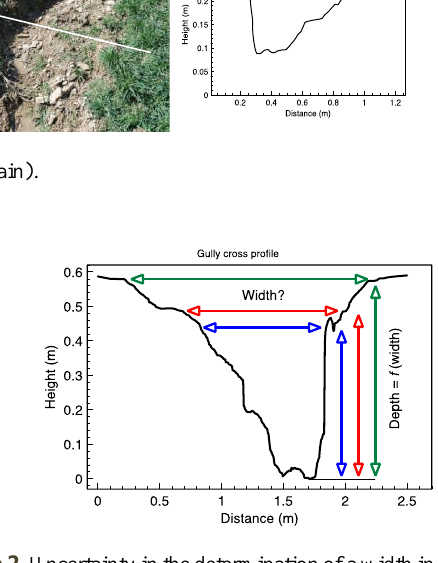
Figure 2. Uncertainty in the determination of a width in a cross sec- tion of a gully (real example). Arrows show different cross section widths and their corresponding depths (same colour). See Sect. 2 for